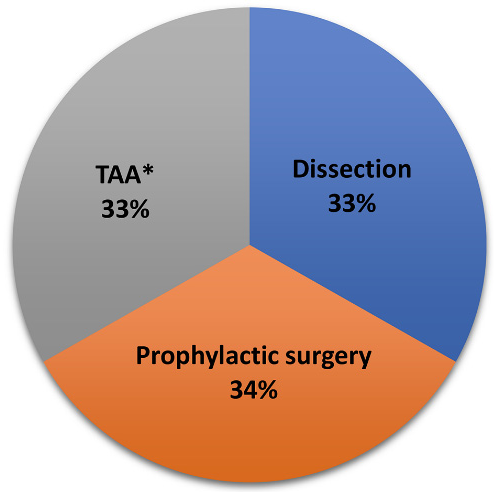
Figure 1. Grouping of cases ( N = 241) into clinical endpoint categories. This study includes cases with history of thoracic aortic dissection ( N = 80), prophylactic thoracic aortic repair surgery ( N = 81), or thoracic aortic aneurysm (TAA) without prior dissection or surgery ( N = 80). In the latter group, marked with an asterisk (*), the maximum proximal aortic diameter averaged 4.5 ± 0.4 cm.